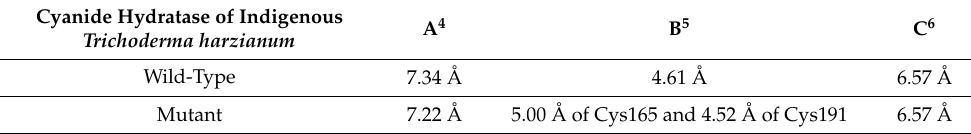
Table 4. MolDock score comparison in wild-type and mutant protein of cyanide hydratase. Type of Protein Table 5. The distance between substrate and catalytic triad in the wild-type and mutant protein.